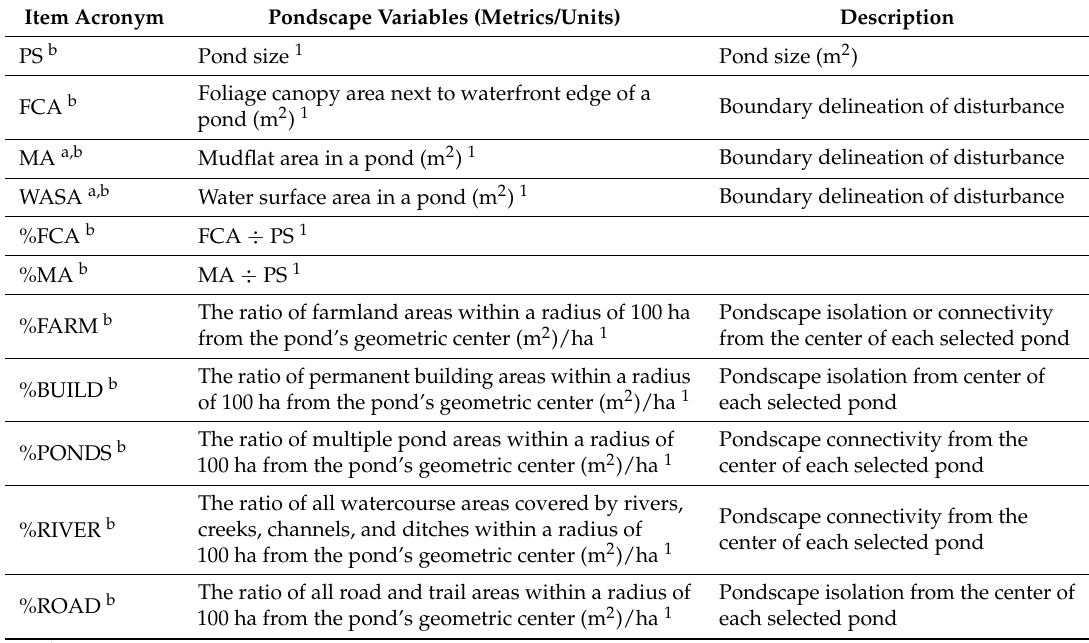
Table 1. Definition and description of metrics used in patch analysis of factors that influence bird